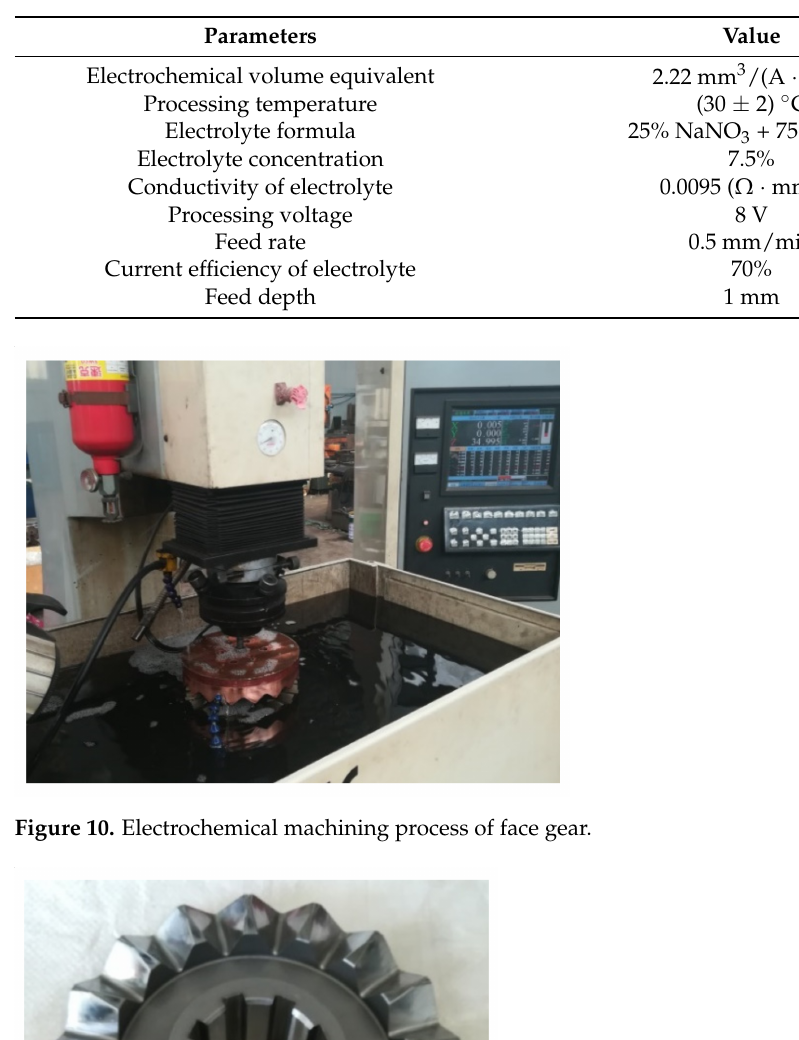
Table 3. Electrochemical machining parameters of face gear.